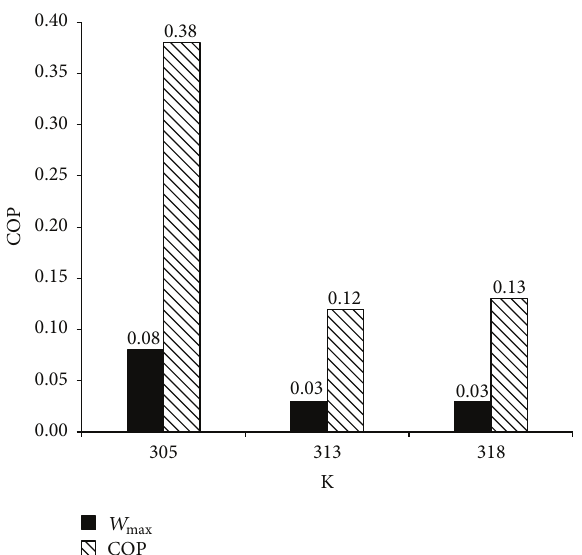
Figure 7: Effect of adsorption temperature on 𝑊 max and COP.